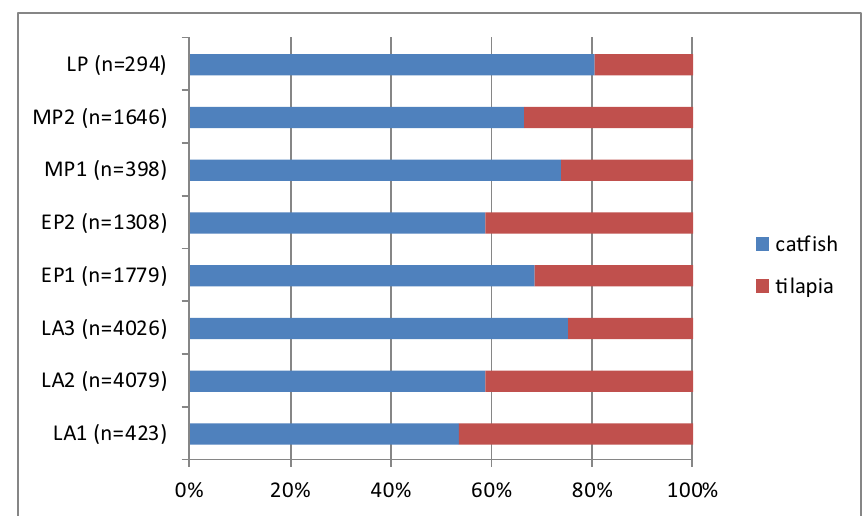
Fig 10. Proportions of the catfish and tilapia in the various chronological phases. For each period the number of remains (n) is indicated on which the percentages are calculated.